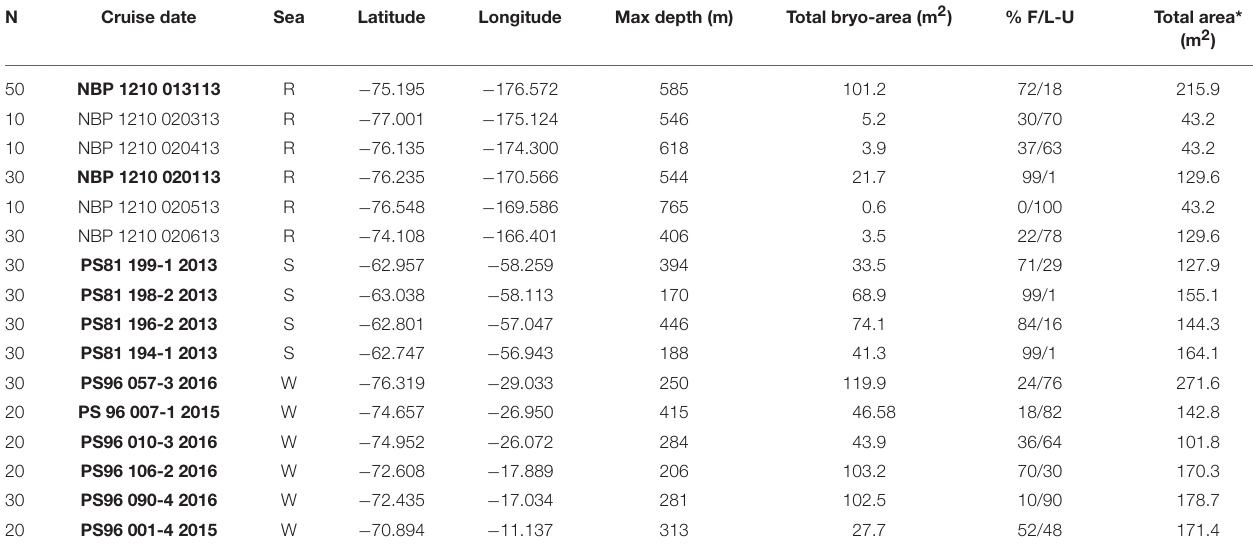
TABLE 1 | Sites in the Ross, Scotia, and Weddell Seas where bryozoan-rich and habitat-forming bryozoan communities were found on the Antarctic